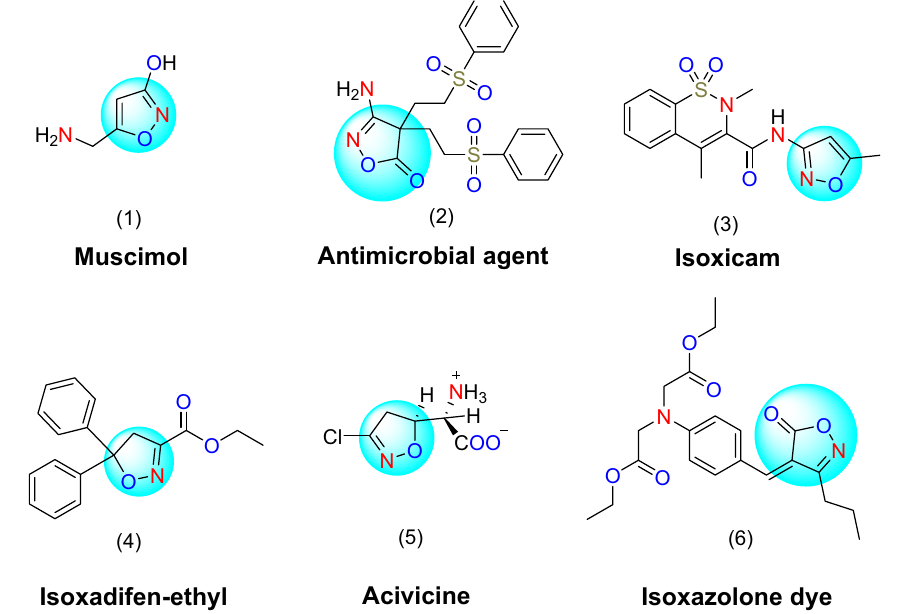
Figure 1. Examples of some isoxazole-containing bioactive compounds and